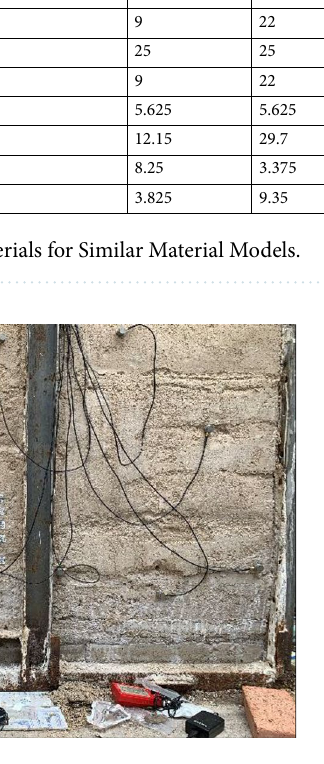
Figure 3. Overall view of the